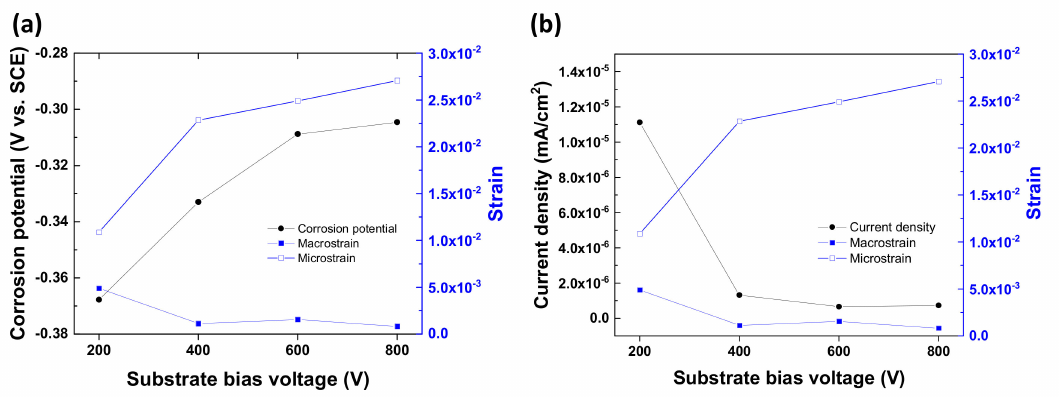
Figure 7. The effect of lattice strain on the corrosion ( a ) potential and ( b ) current density. To examine the texture variation of Nb-coated 316L, the degree of orientation ( α (hkl) ) was calculated. In Figure 8, the degree of orientation toward the (110) plane increased as bias voltage increased. This means that the homogeneous Nb-coated layer is preferentially oriented toward the (110) plane due to a higher bias voltage. The texture variation of Nb-coated 316L indicated that corrosion resistance was improved with an increasing ratio of (110) texture. Because the (110) plane is the most densely packed in metal Nb with a BCC structure, it has stronger atomic binding energy than other planes of lower packing density. Thus, the dissolution of metal ions in the corrosive environment was inhibited. The obtained results suggest that the texture variation, due to bias voltage, affects corrosion behavior significantly. The increased bias voltage induces a strong texture for the (110) plane, which contributed to improved corrosion resistance.